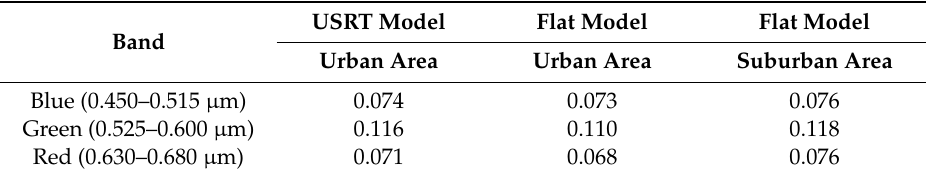
Table 3. Reflectance comparison of pure grassland pixels derived from the two models in the urban and suburban area.